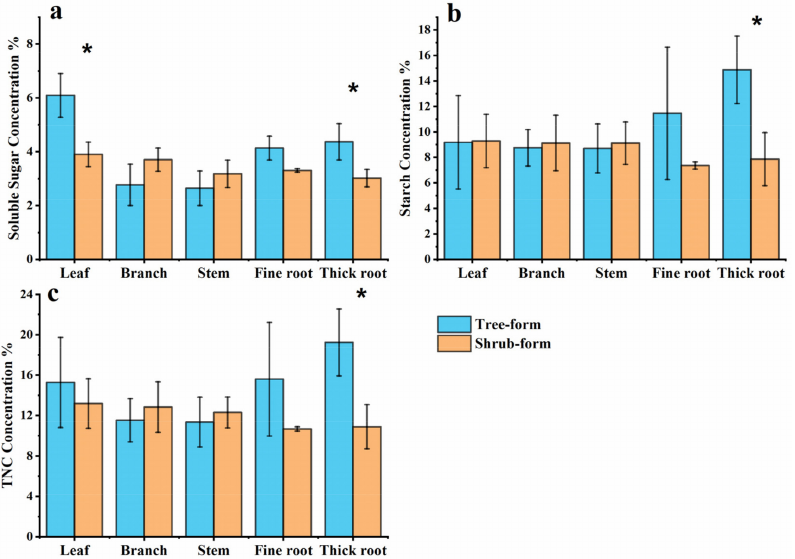
Figure 5. Effects of growth form on NSC concentration in saplings. Changes of ( a ), soluble sugar, ( b ), starch and ( c ), TNC concentration of each organ. Asterisks indicate that MANOVA shows significant differences between the two growth forms (*, p <